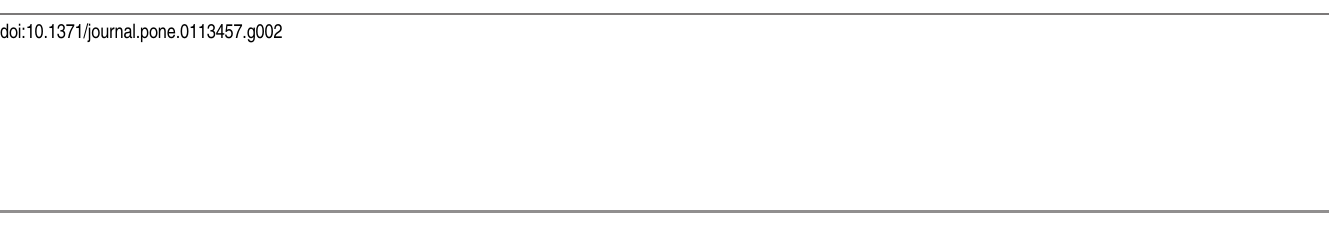
Figure 2. Degree distributions and degree correlations. All degree distributions are power-law-like. d u 4th rows, where red and black lines representing the results from original and reshuffled networks. Results of reshuffled networks are obtained by averaging over five independent